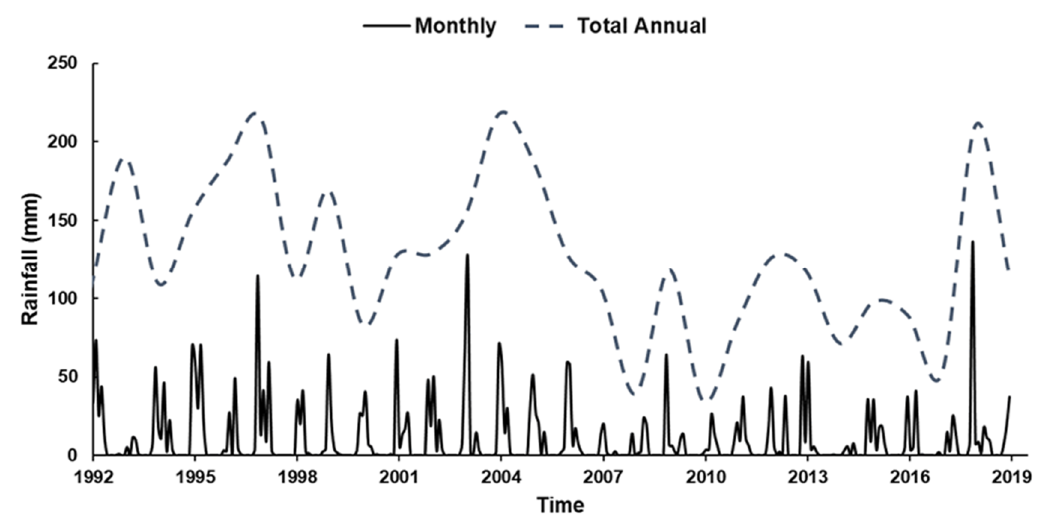
Figure 2. Total annual and monthly precipitation at the Kuwait International Airport (KIA) weather station from 1992–2019.